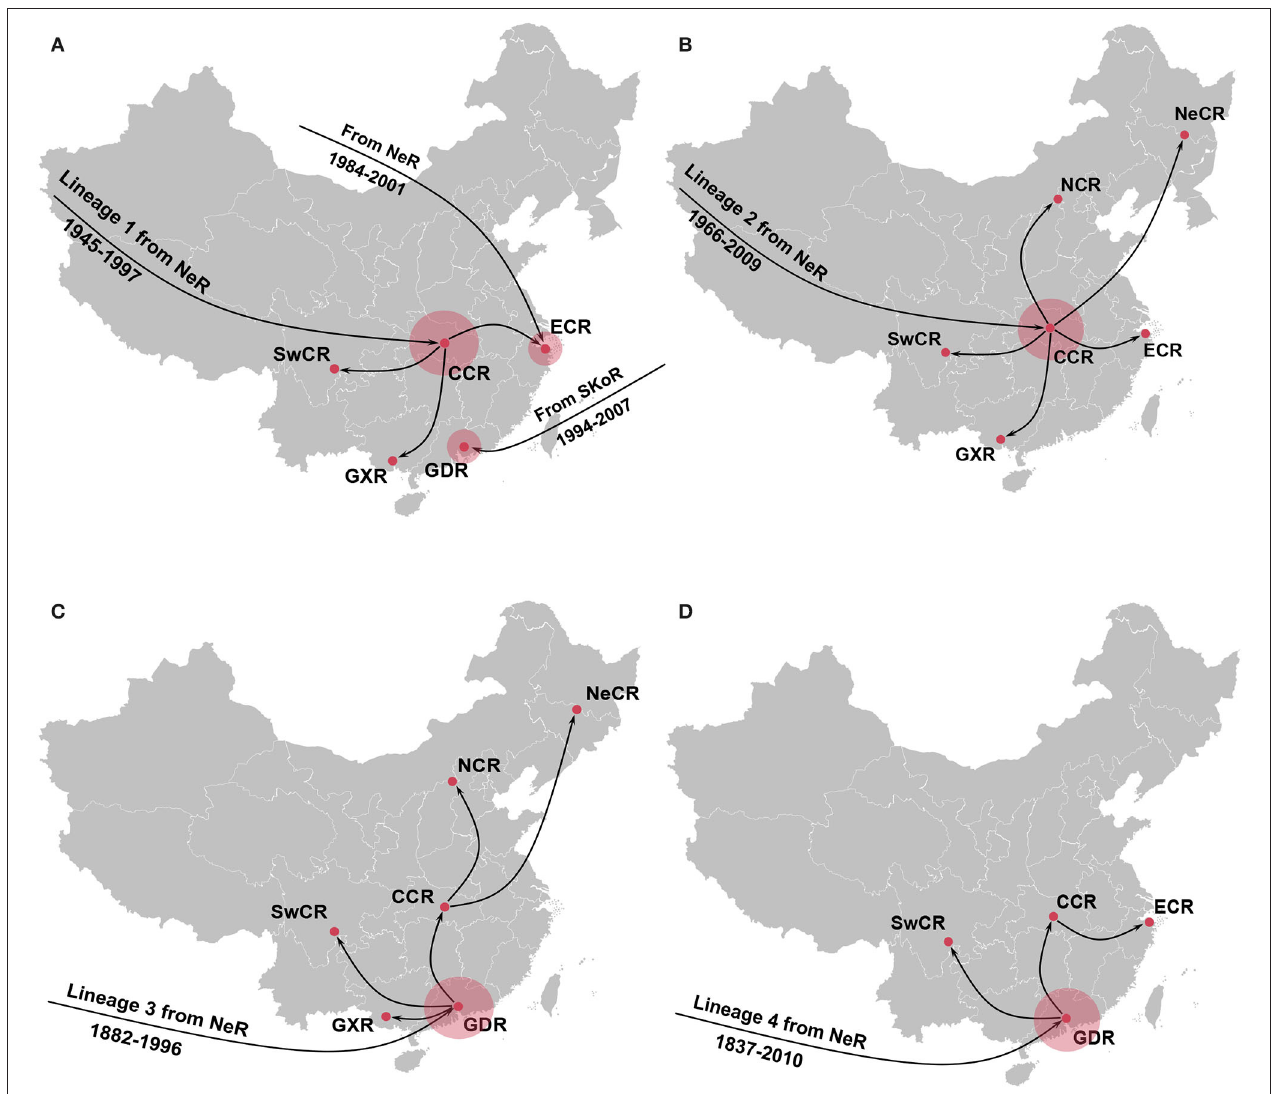
FIGURE 4 | Spatial dynamic of atypical porcine pestivirus lineage 1 (A) , lineage 2 (B) , lineage 3 (C) , and lineage 4 (D) in China. Red circles indicate the introduction mainly from the Netherlands seeding transmission pathways in China. NeR, Netherlands Region; SwCR, Southwest China Region; NeCR, Northeast China Region; NCR, North China Region; ECR, East China Region; CCR, Central China Region; GXR, Guangxi Region; GDR, Guangdong